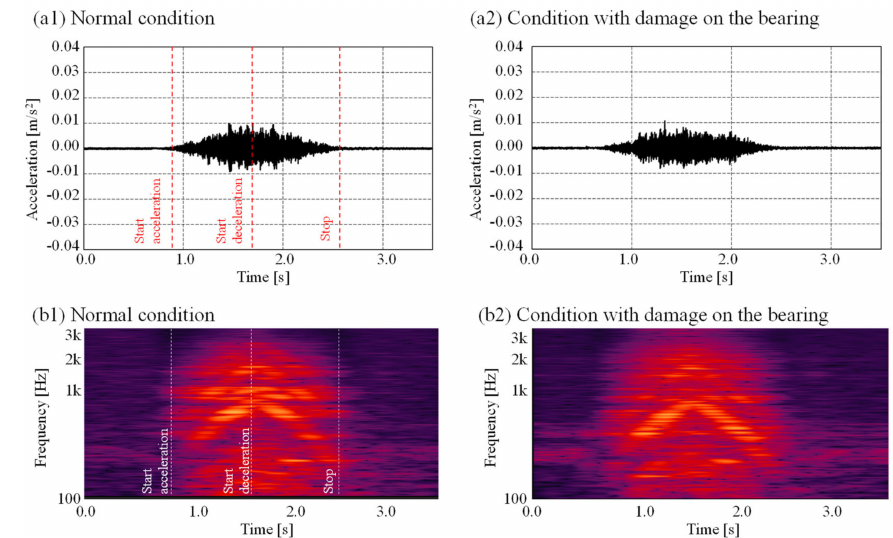
Figure 16. Acceleration waveforms and their spectrograms for the lifter ( a1,b1 ) in the normal state and ( a2,b2 ) operating with a damaged bearing: As shown in Figure 16( a1 ) and ( b1 ), the waveform starts to sweep up after around 0.9 s when the lifter starts to accelerate; after that, the waveform starts to sweep down after 1.8 s; then finally, the large fluctuation of the waveform finishes at around 2.8 s when the lifter stops. The di ff erences between the normal and damaged conditions observed in the time waveform and spectrogram are relatively small compared to those shown in Figure